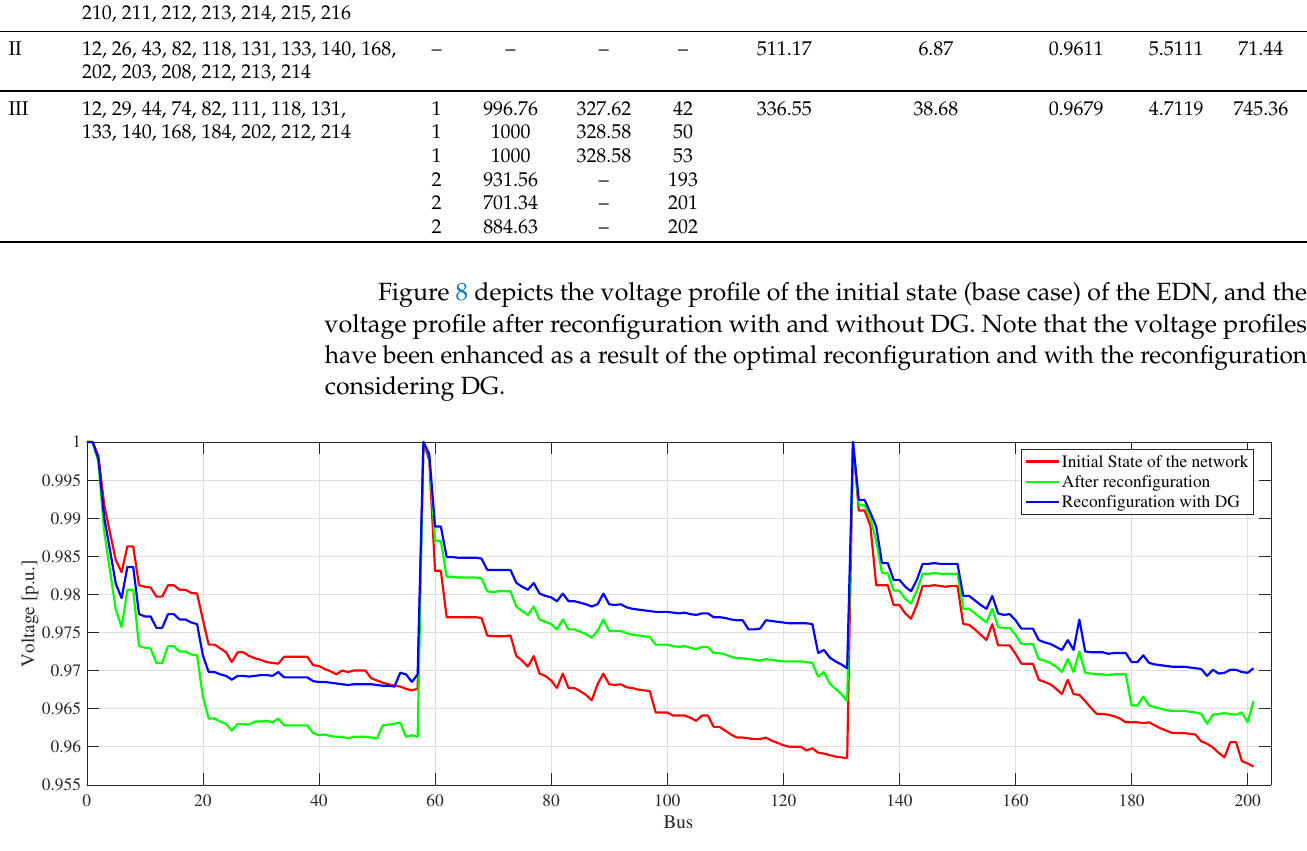
Figure 8. Voltage profile of the 202-bus test